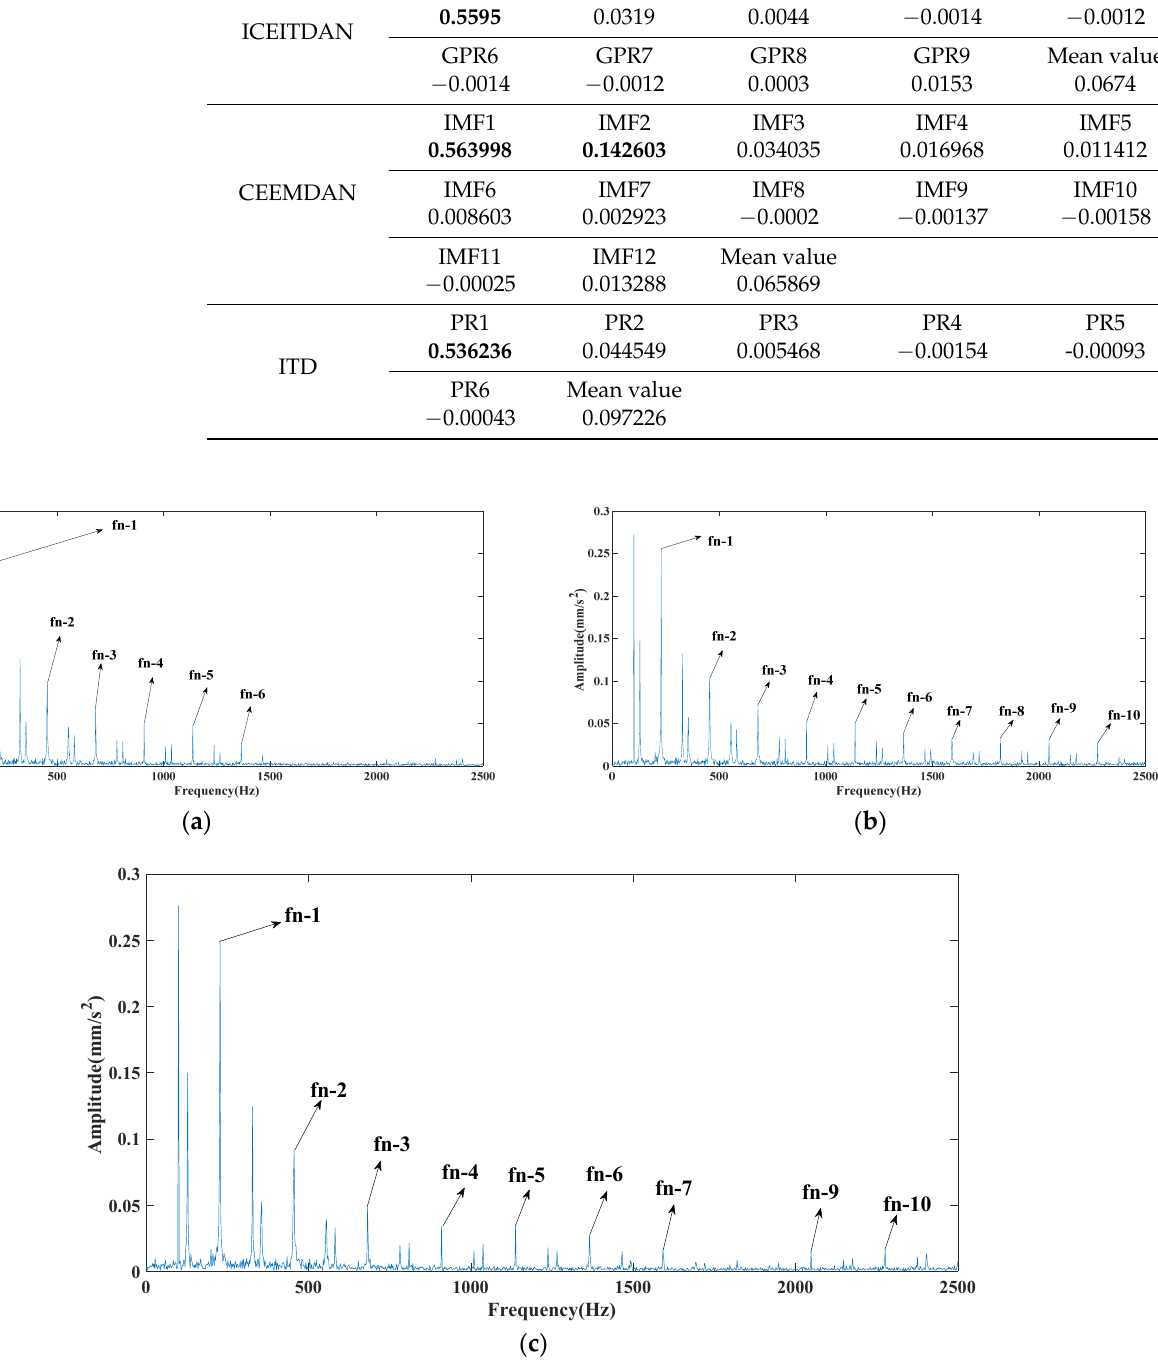
Figure 5. Comparison chart of envelope spectrum results of the three methods: CEEMDAN, ICEITDAN, and ITD. ( a ) ITD, ( b ) ICEITDAN, and ( c ) CEEMDAN.